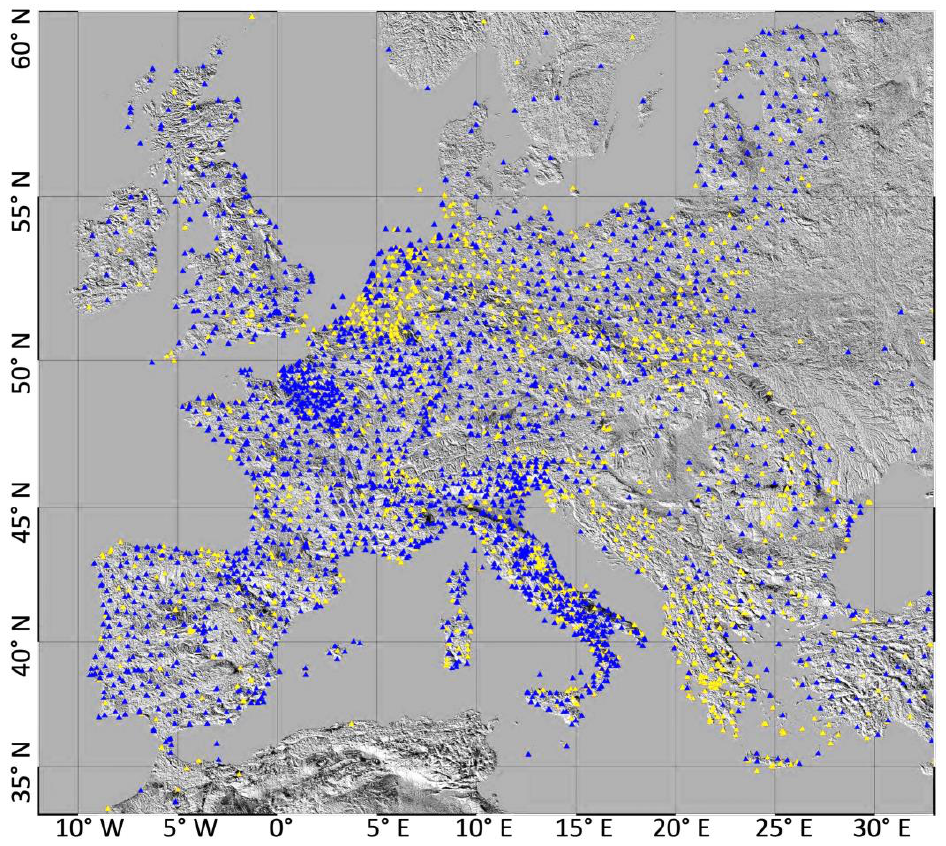
Figure 10. Overall GNSS stations analysed in the presented study. Blue and yellow markers represent the exploited and the discarded stations, respectively, following the screening and selection procedure discussed in Section 3.